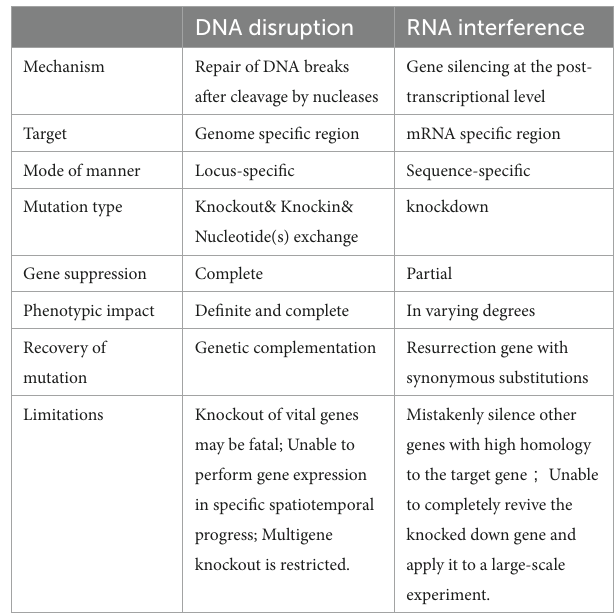
TABLE 2 Systematic comparison of DNA disruption and RNA